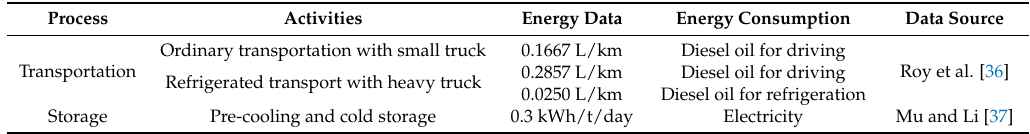
Table 1. The energy consumption data in cold chain.